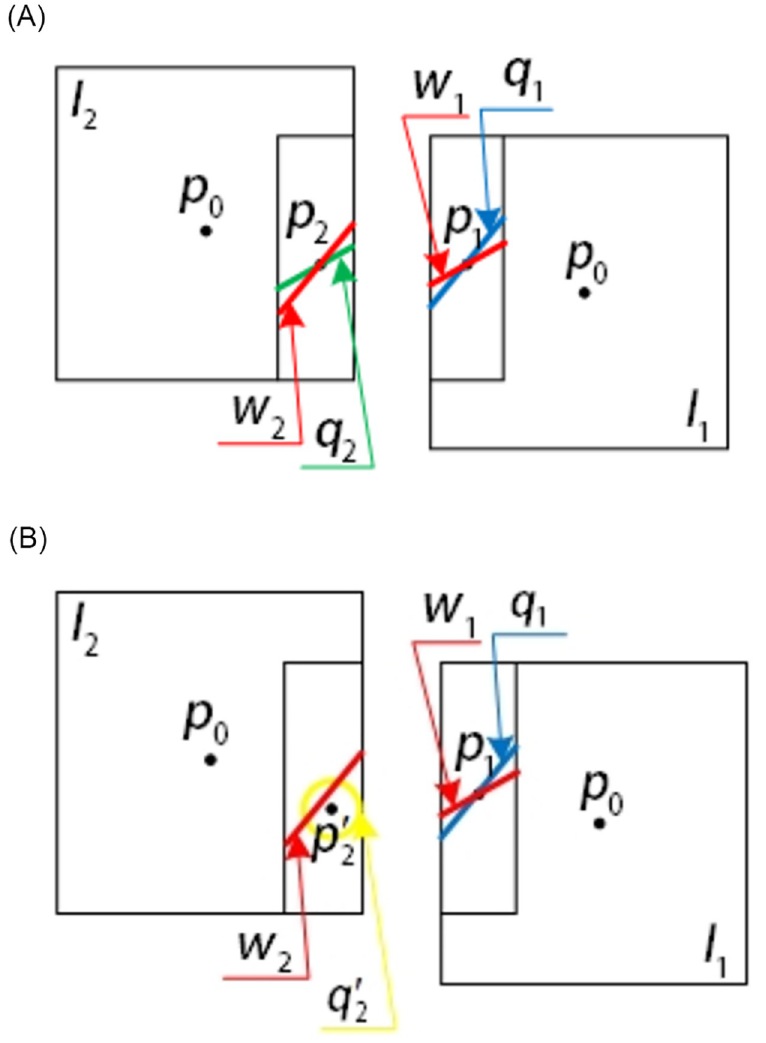
Fig 6. Form of image epipolar constraint on image